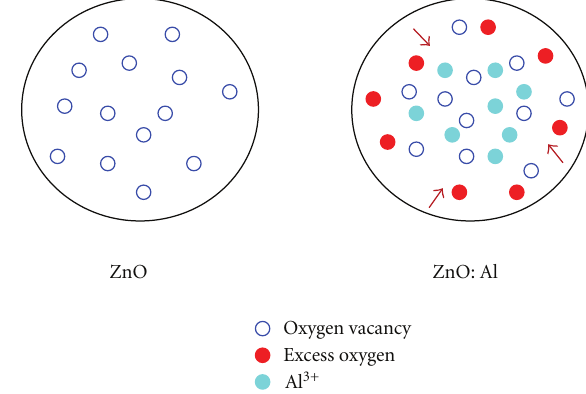
Figure 7: Schematic representation of defects in ZnO and ZnO: Al films. The red arrows indicate the di ff usion of excess oxygen to the ZnO grain due to the presence of Al